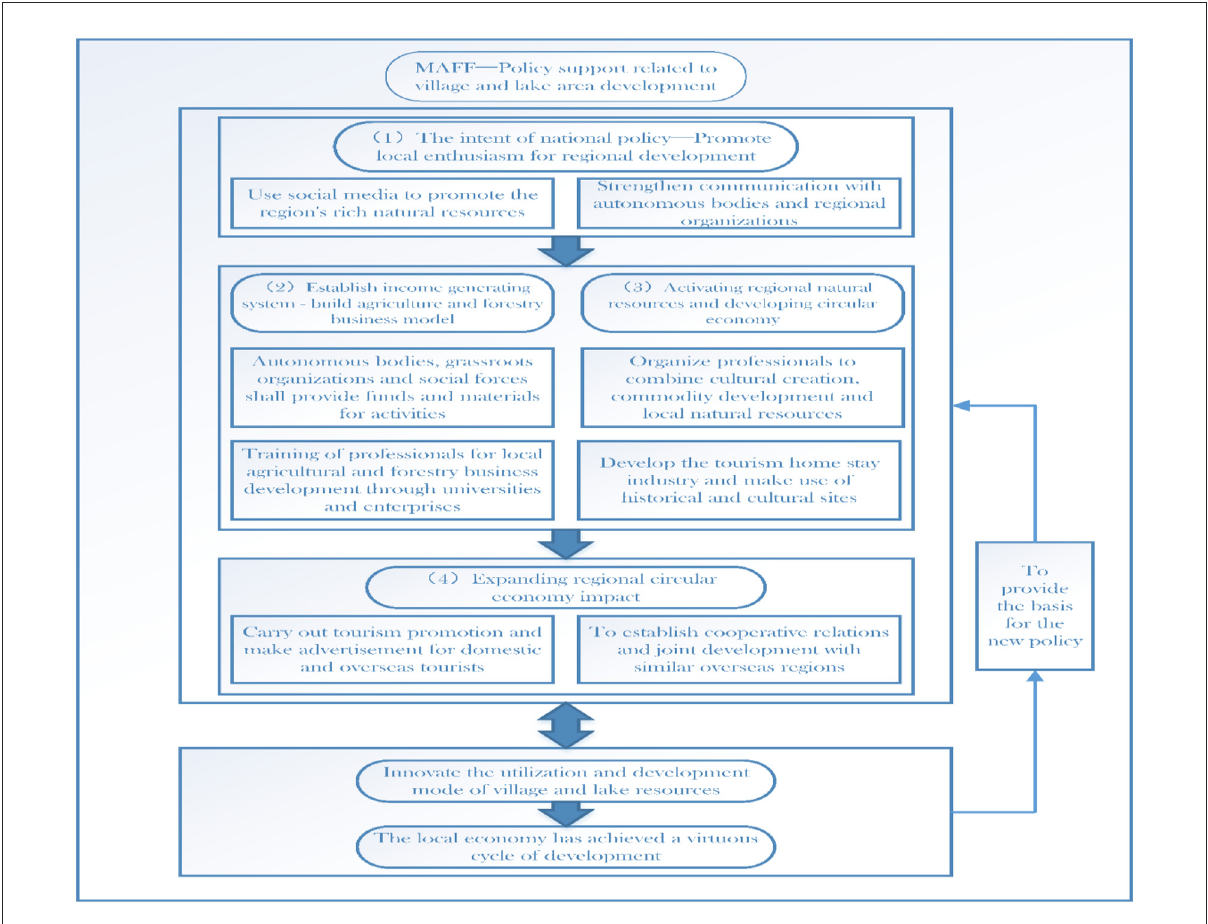
FIGURE9 The ministry of agriculture, forestry and fisheries’ leading role in the development planning of forest